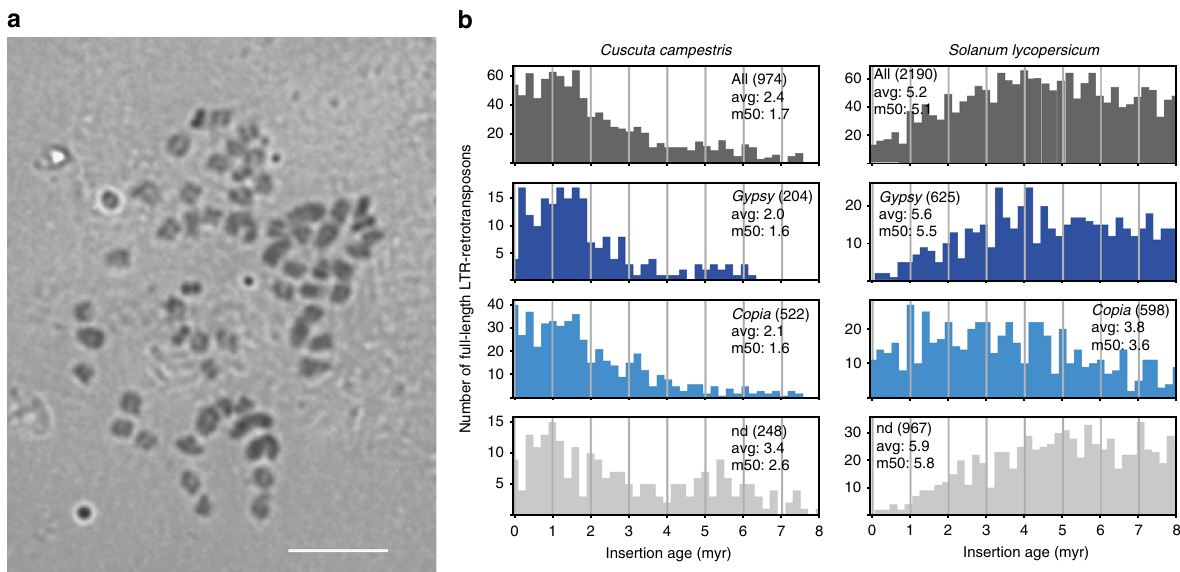
Fig. 2 Genome features. a Feulgen-stained metaphase chromosomes of C. campestris (2 n = 56). The scale bar represents 10 µ m. b Insertion age distribution of C. campestris full-length LTR retrotransposons in comparison to tomato ( Solanum lycopersicum ) as another Solanales representative. Insertion events of long terminal repeat (LTR) retrotransposons were dated by comparing the divergence between the 5 ′ and 3 ′ long terminal repeats 61 . A random mutation rate of 7*10 − 9 was used to convert the sequence divergence into age 62 (in million